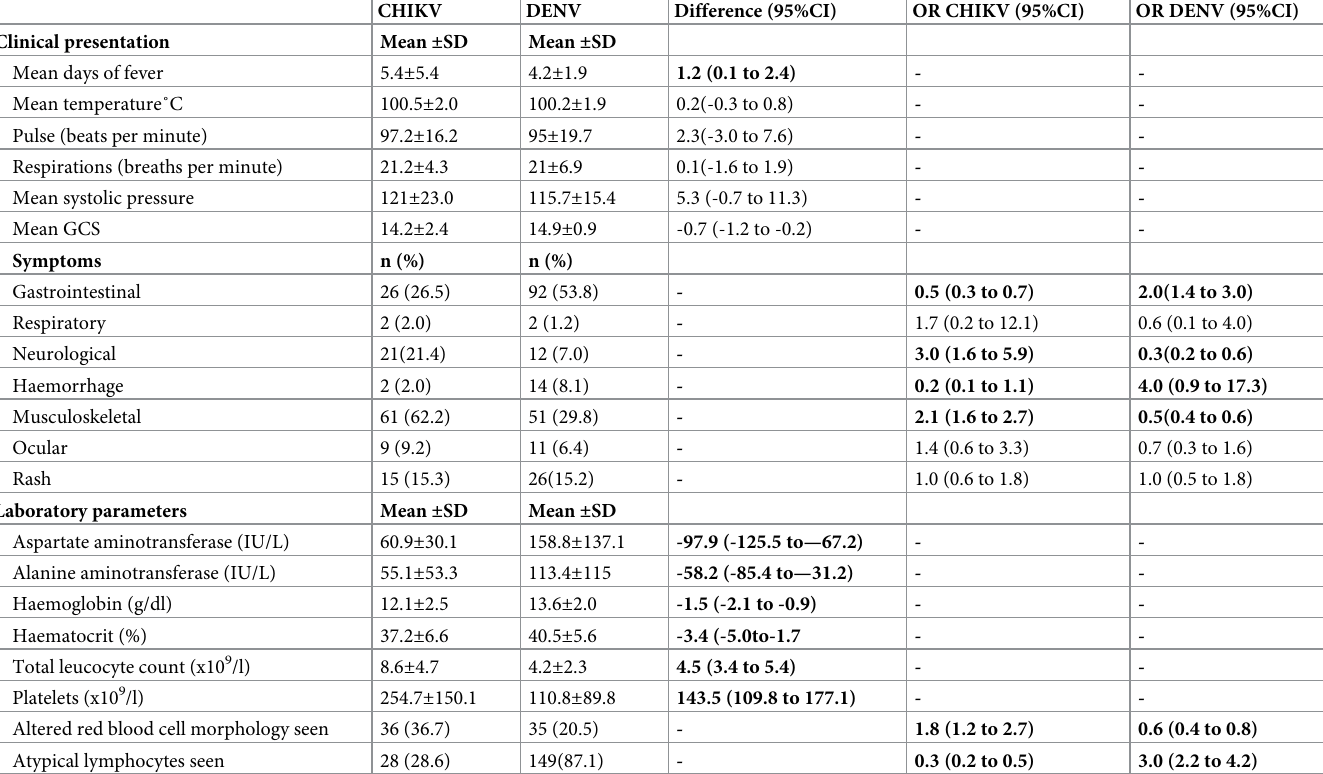
Table 2. Clinical presentation and laboratory findings of acute febrile patients with Dengue virus and Chikungunya virus infection from Sindh, Pakistan 2015– 2017 (Bold font indicates statistical significance).